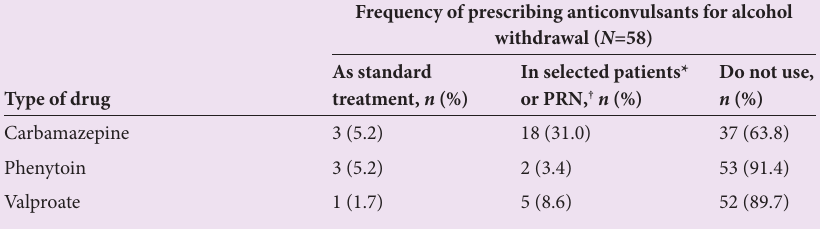
Table 5. Use of anticonvulsants in alcohol withdrawal Frequency of prescribing anticonvulsants for alcohol